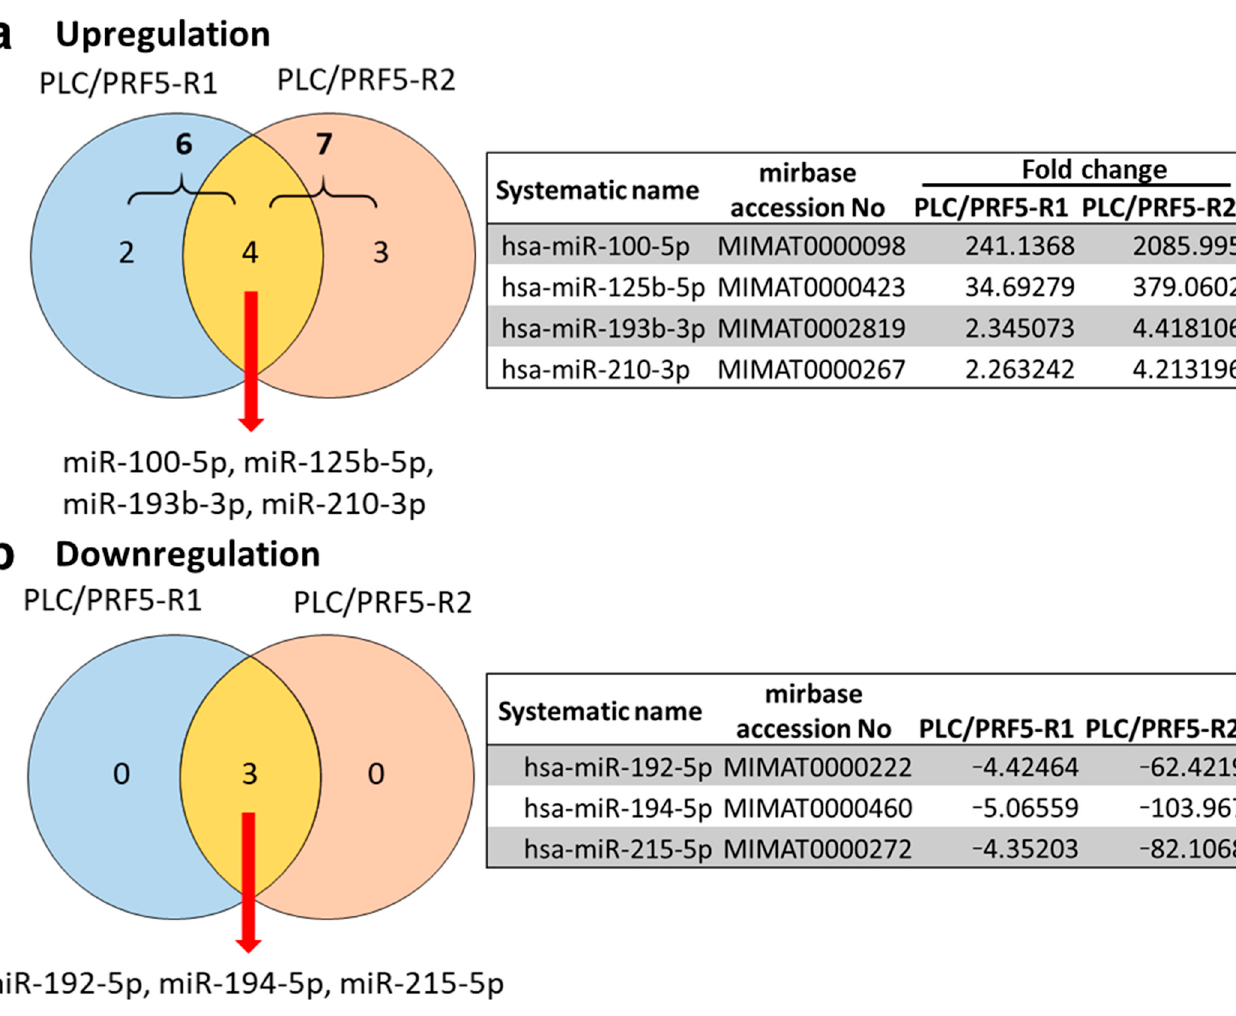
Figure 1. Differentially expressed miRNAs in sorafenib-resistant hepatocellular carcinoma (HCC) cell lines PLC/PRF5-R1 and PLC/PRF5-R2. The miRNA expression profile was compared between PLC/PRF5-R1 or PLC/PRF5-R2 and parental PLC/PRF5. Venn diagram of the differentially expressed miRNAs in PLC/PRF5-R1 and PLC/PRF5-R2 cells (fold change > 2, signal intensity > 100), and the miRNA list identified in the common part of the Venn diagram are shown. ( a ) Upregulated miRNAs. ( b ) Downregulated miRNAs.